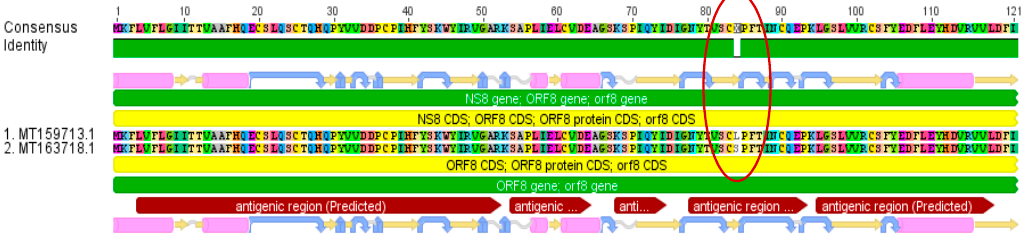
Figure 2. NS8 gene amino acid alignment (MT159713/MT163718) with a confirmed variation Leucine → Serine in an antigenic region occurring in 27% of all analyzed